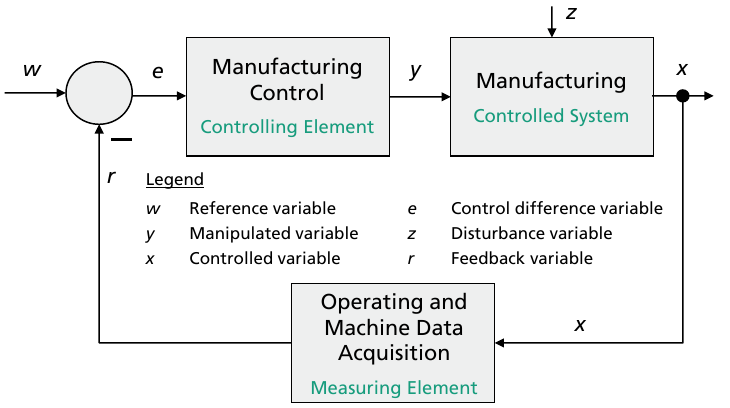
Figure 2. Transferring the principle of closed-loop control to manufacturing (adapted from [41]).